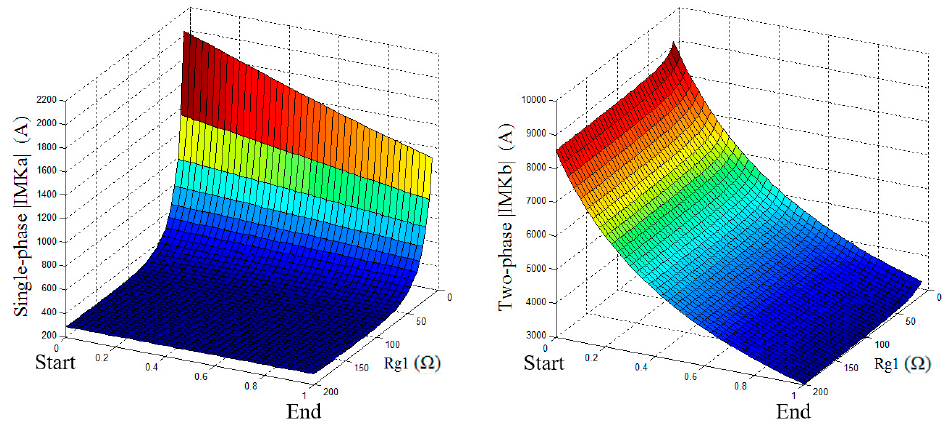
Figure 15. Change characteristic of the fault phase current with respect to fault location and Rg 1.